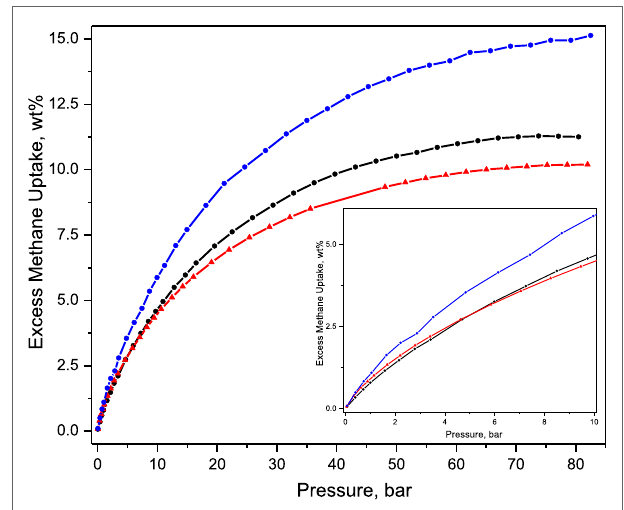
FigUre 4 | excess methane uptake on Mil-101 (black), nh 2 -Mil-101 (red), and PsM (blue); isotherm at low methane loading in insert .